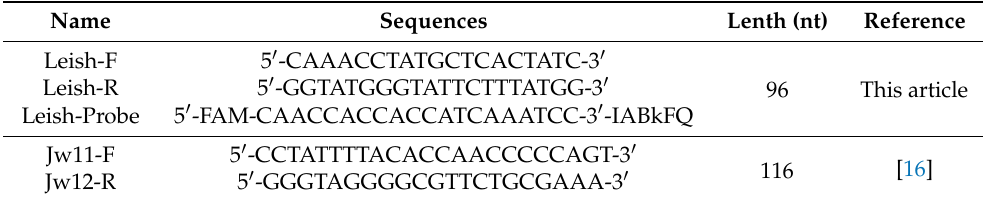
Table 1. Primers and probe used for Leishmania detection.